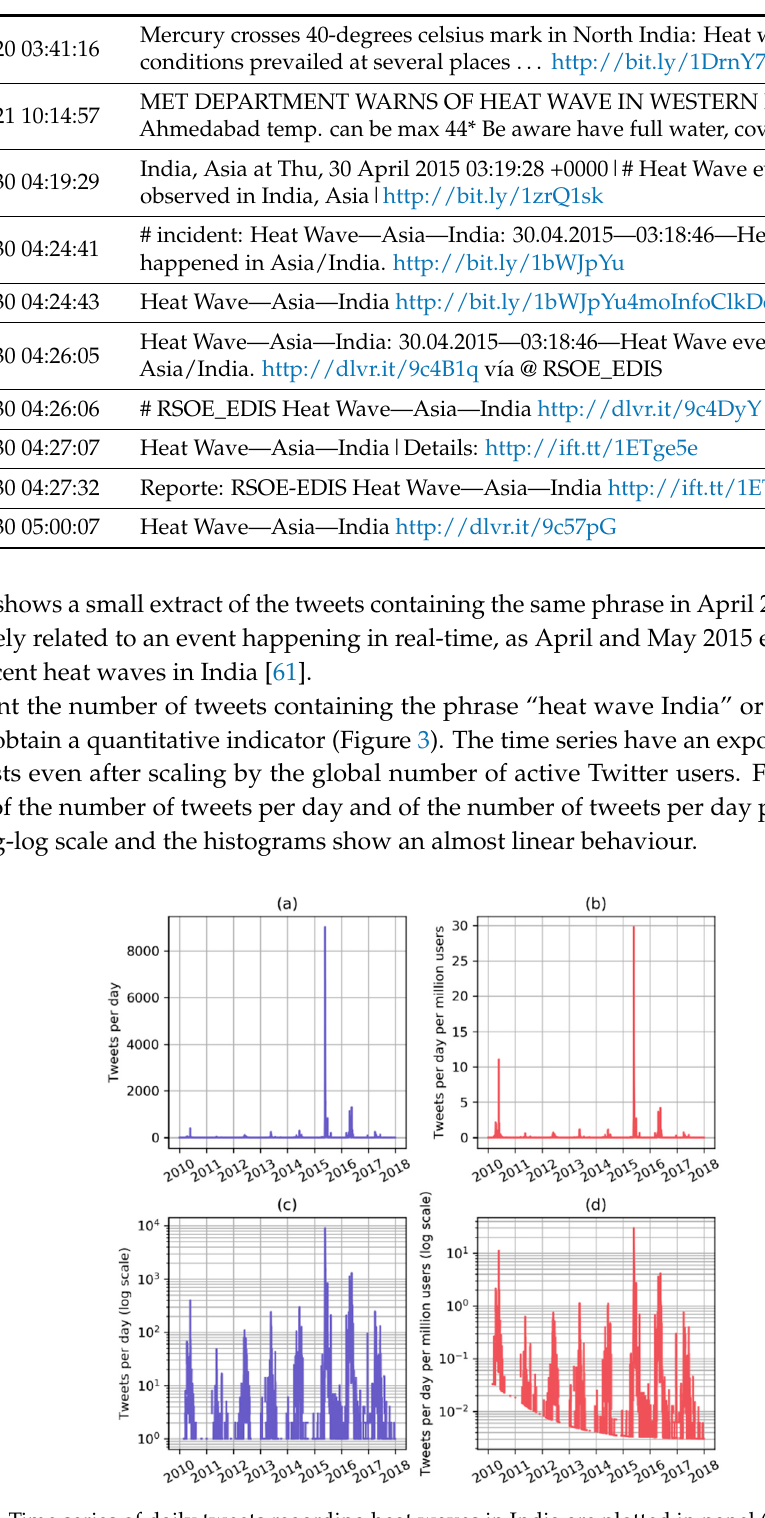
Figure 4. Histograms representing the distribution of the number of tweets per day ( a ) and the number of tweets per day per million users ( b ).